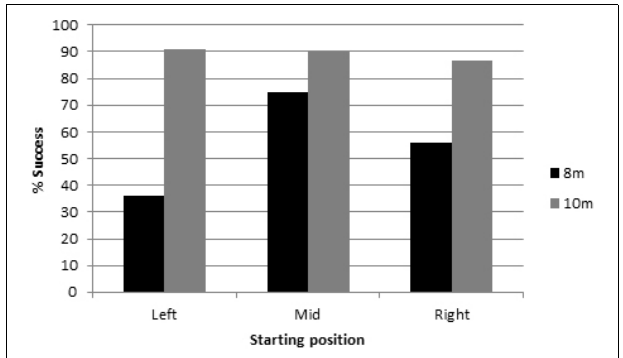
FIGURE 3 | Frequency of successful grasping in the three object positions as a function of age group.